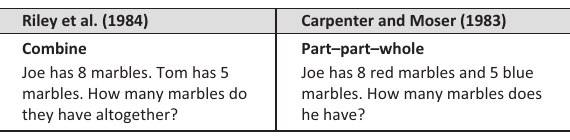
FIGURE 1: Comparison of two ‘original’ word problem typologies.